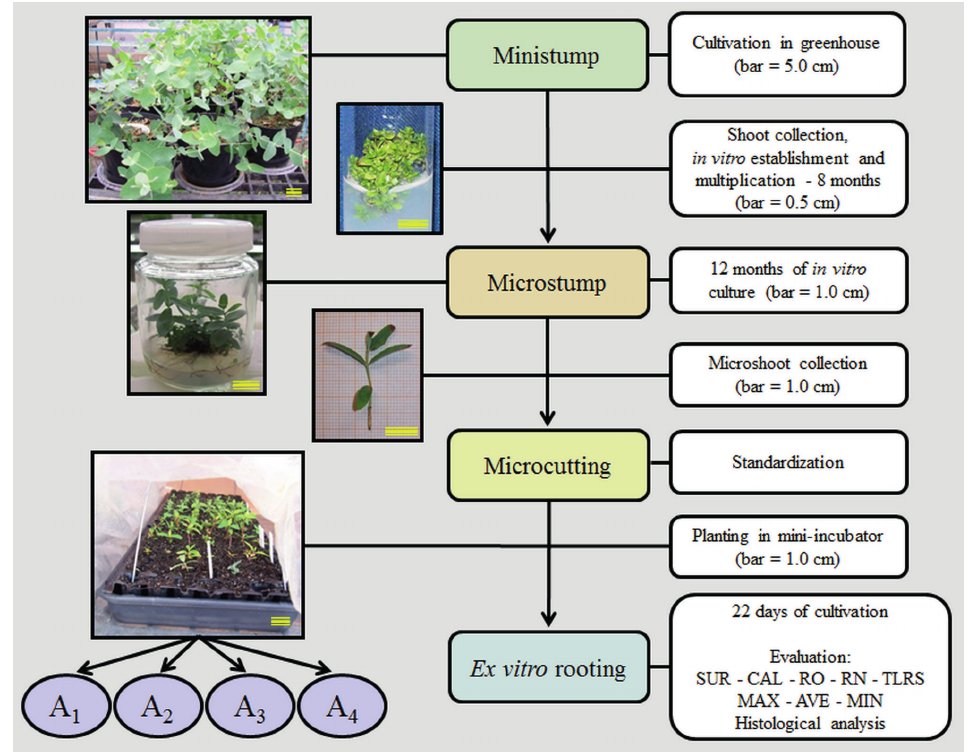
– mini- Figure 1 - Flowchart of Eucalyptus benthamii micropropagation under different environments. A 1 incubator placed in a shade house (50%) with no fogging system; A – mini-incubator in a greenhouse 2 with ventilation and no fogging; A – mini-incubator in a greenhouse with ventilation and fogging; A 3 4 – mini-incubator in a greenhouse with no ventilation but with fogging. SUR – survival percentage; CAL – callogenesis percentage; RO – adventitious rooting percentage; RN – number of roots; TLRS – total length of the root system; MAX – maximum air temperature; AVE – average air temperature; MIN – minimum air temperature (measured daily at 09:30 h, 12:30 h, 15:30 h, and 18:00 h). Corymbia citriodora and Eucalyptus urophylla were submitted to the same